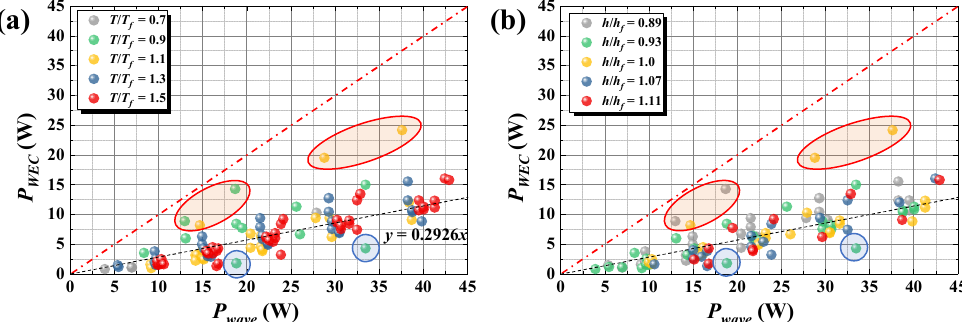
Figure 18. Relationship between P wave and P WEC depending on ( a ) T / T f , and ( b ) h / h f . Open red and blue circles denote the ranges of high and low k e .